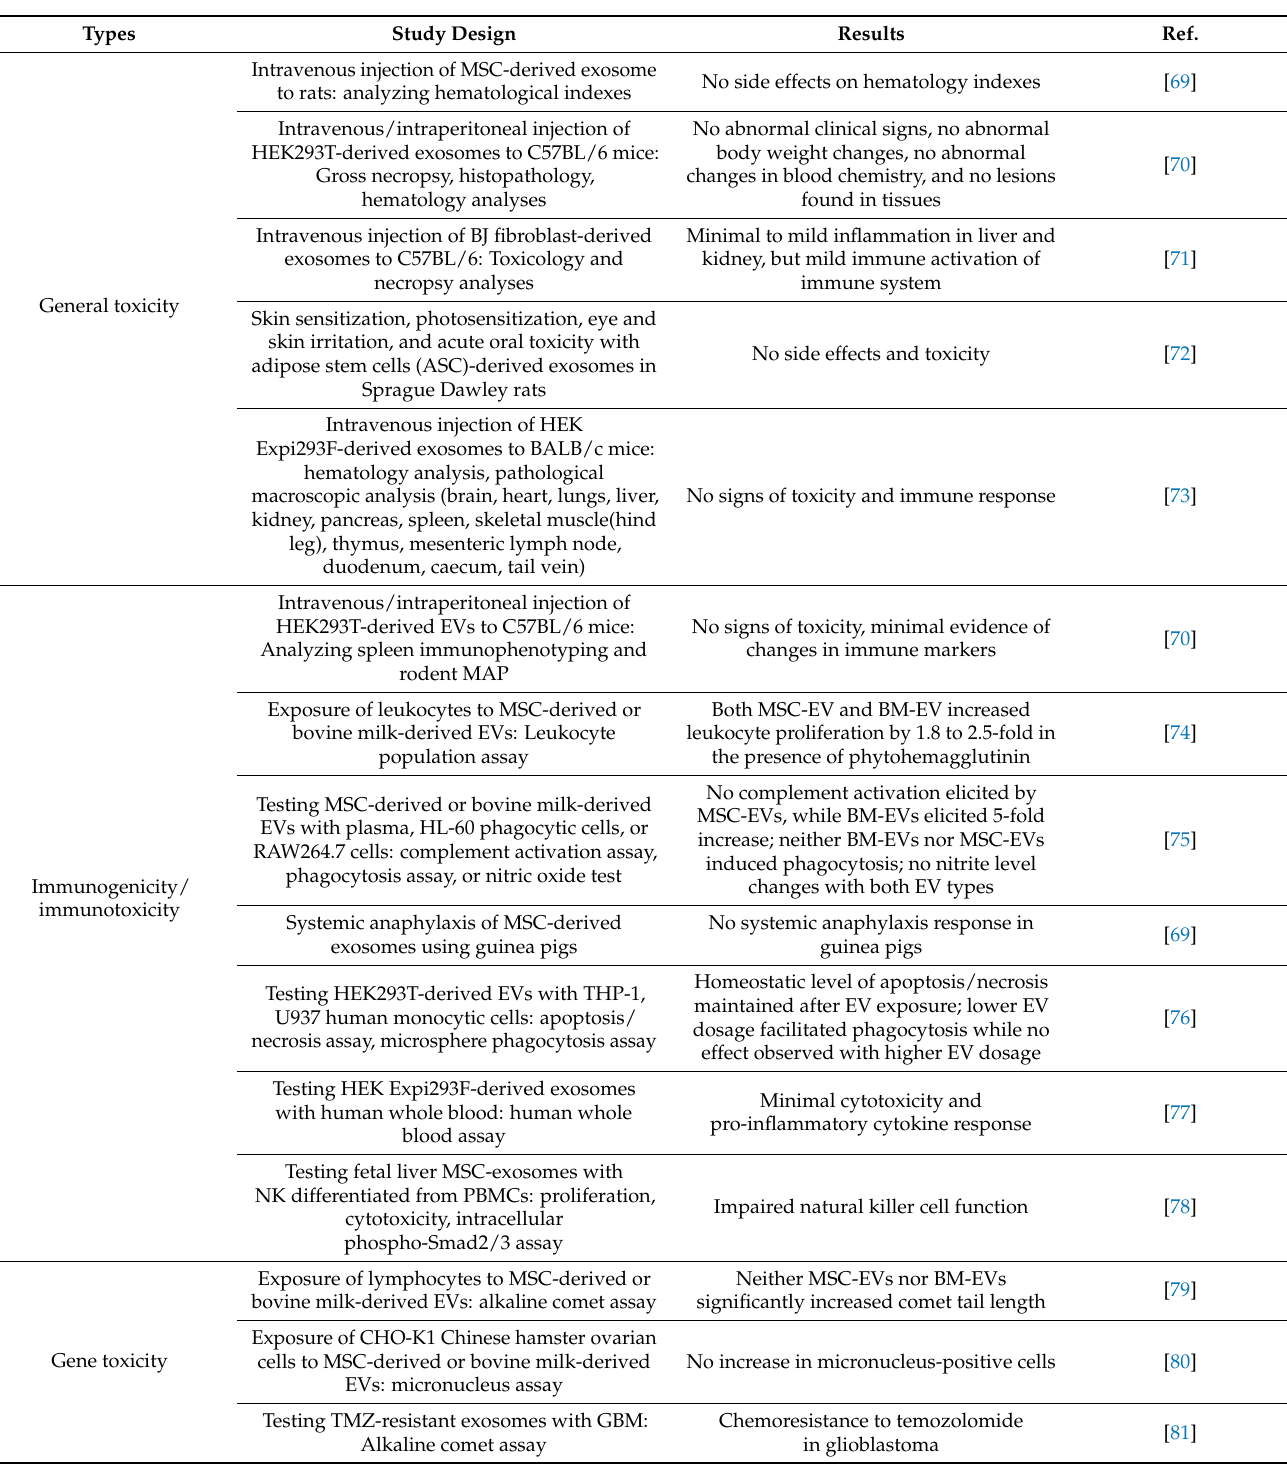
Table 2. EV toxicity and safety